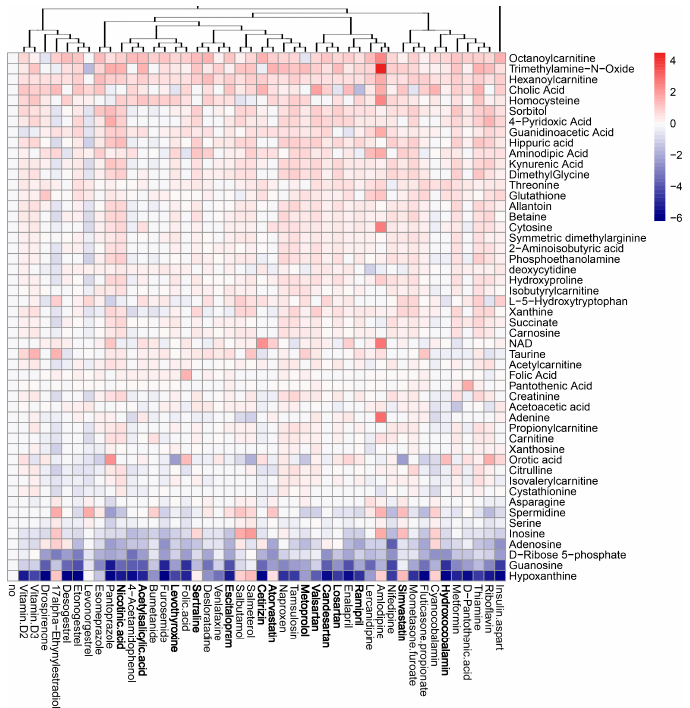
Figure 7. Effect of 45 compounds on metabolism of polar molecules in mock-infected RPE cells. The cells were treated with 10 μ M compounds or remained non-treated. After 24 h, the media were collected, and polar metabolites were analyzed using LC-MS/MS. A heatmap of 50 most vari- able metabolites affected by treatment is shown. Rows represent metabolites, columns represent treatments with drugs, clustered based on structural similarity. Drugs marked in bold are com- pounds which were predicted to affect FLUAV–host cell interactions. Each cell is colored accord- ing to the log2-transformed and quantile-normalized values of the samples, expressed as fold change relative to the non-treated control.